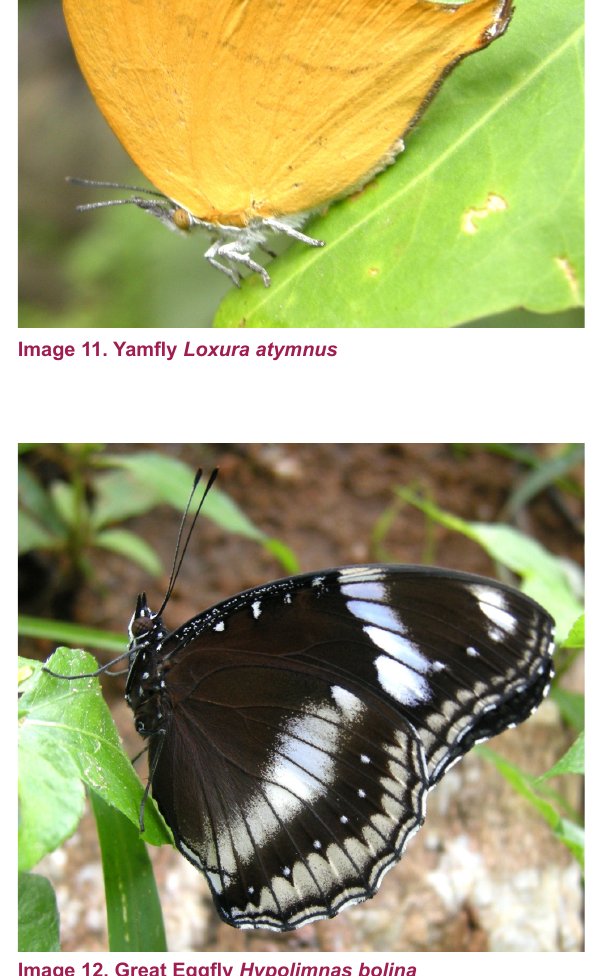
Image 12. Great Eggfly Hypolimnas bolina